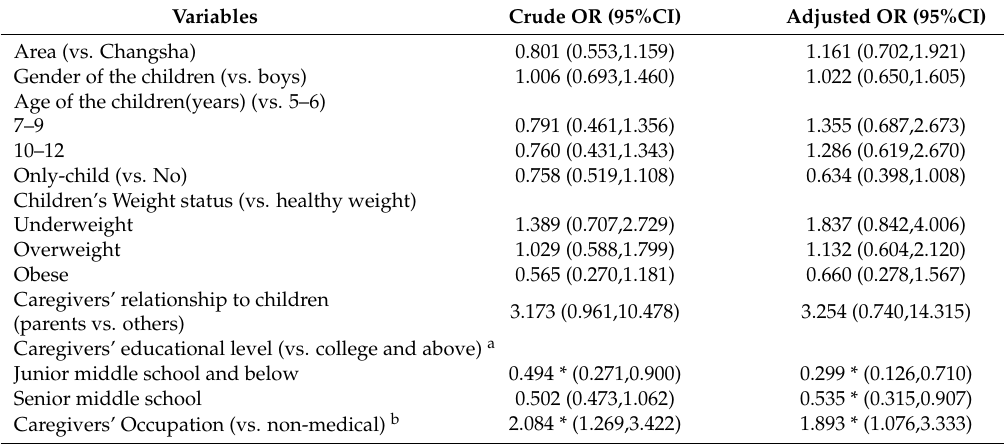
Table 2. Logistic regression analysis of the factors in dietary supplement use among school children.